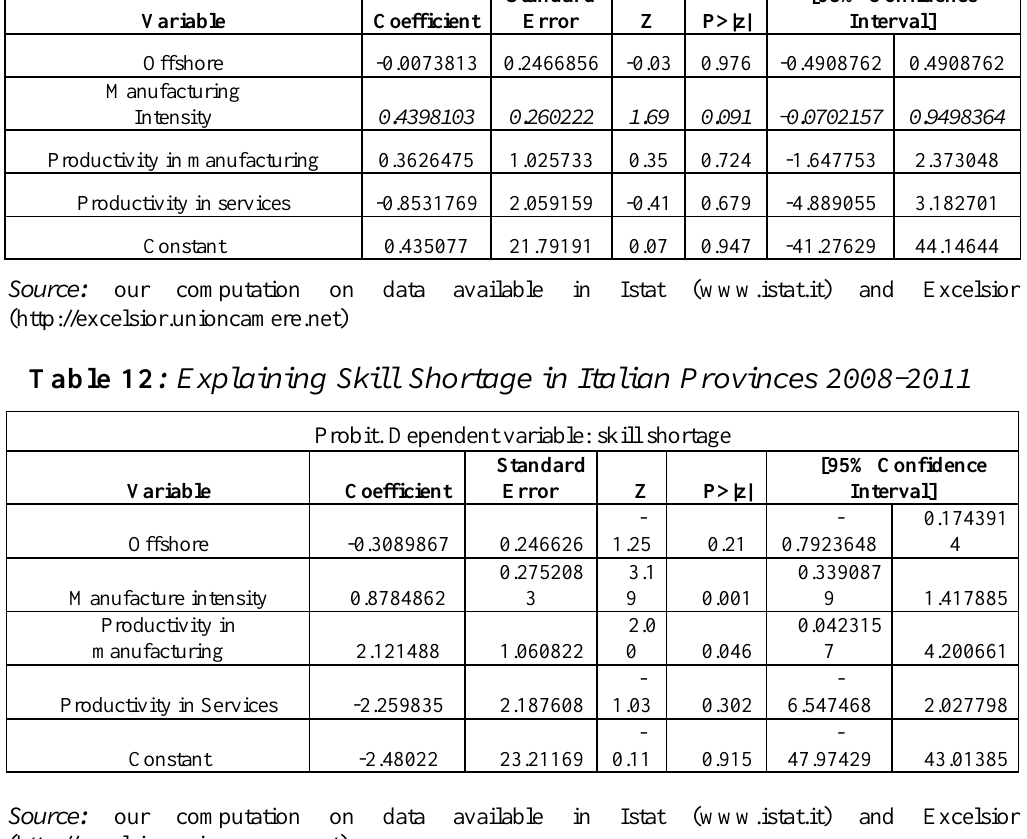
Table 11: Explaining High Skill Labor Demand in Italian Provinces 2008-2011 Probit. Dependent variable: high skill labor demand Variable Coefficient